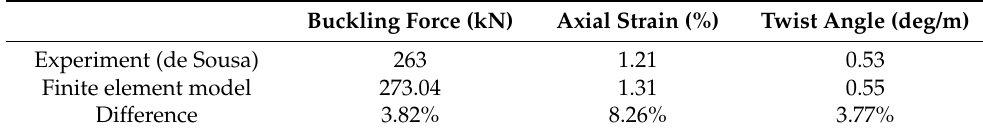
Figure 12. Model verification: ( a ) axial compression-shortening curves of the flexible riser; ( b ) axial compression-twist curves of the flexible riser; ( c ) axial compression-radial expansion curves of the flexible riser. Table 6. Difference between finite element model and